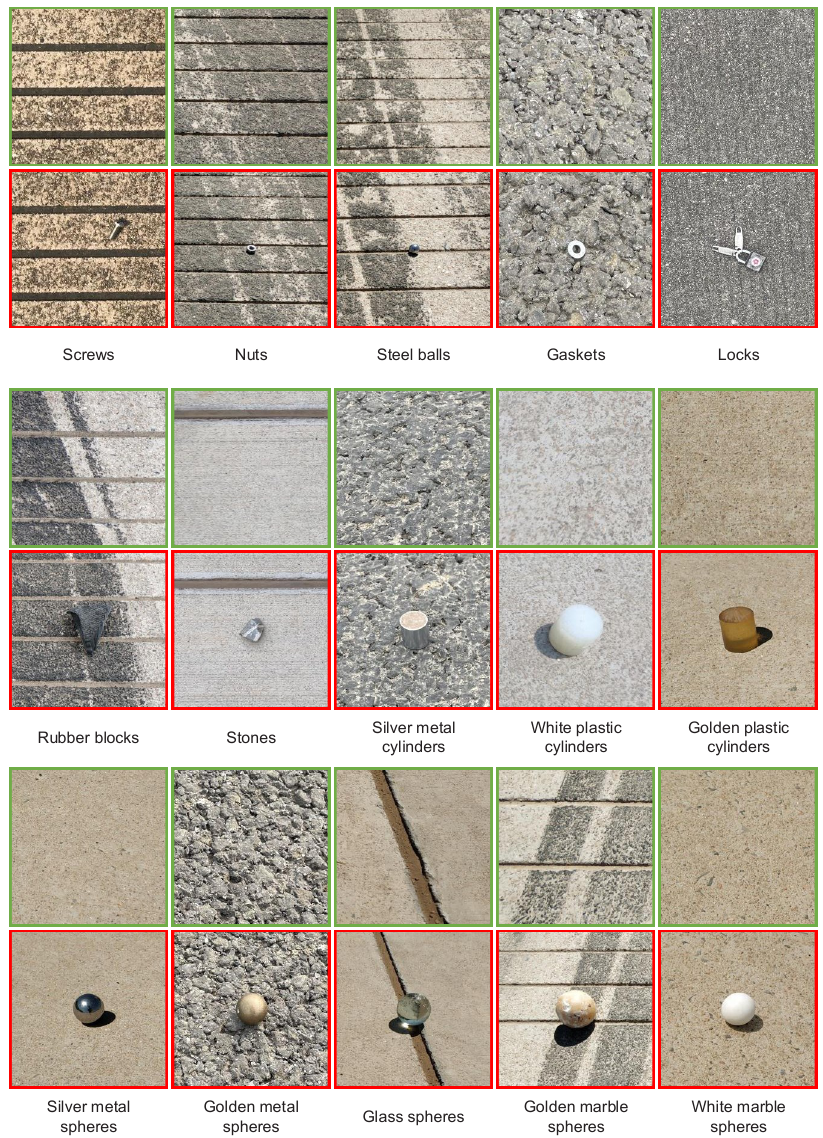
Figure 4. Examples of normal and abnormal images for each class on FOD dataset. For each class, the top row shows normal images without FOD, and the bottom shows abnormal images with